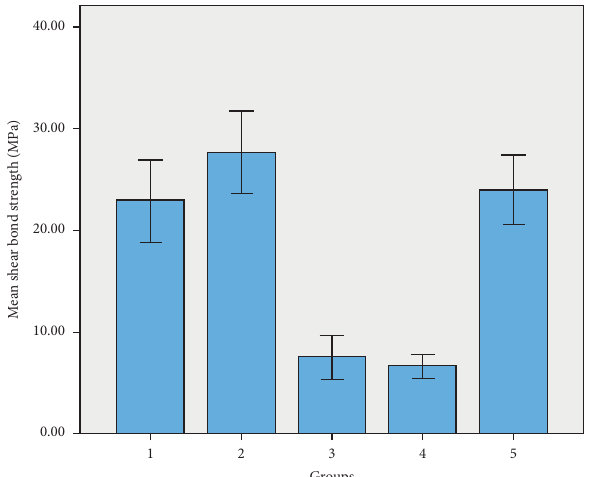
Figure 3: Means of the shear bond strengths (MPa) in the study groups. 1: (G1) 37% phosphoric acid and 10% papain. 2: (G2) 37% phosphoric acid and 6% bromelain. 3: (G3) 6% bromelain. 4: (G4) 10% papain. 5: (G5) 37% phosphoric Table 2: Comparison of mean shear bond strength values between the study groups. Study groups